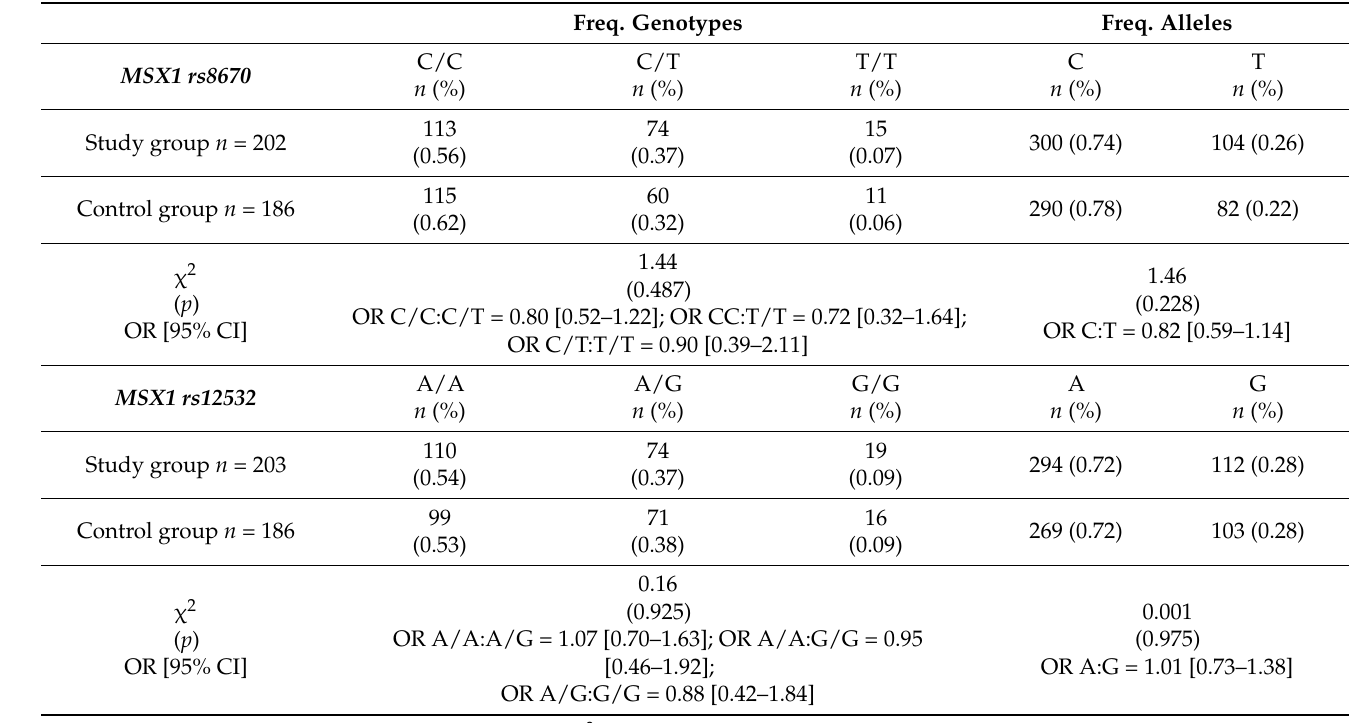
Table 5. Frequency of genotypes and alleles of the MSX1 rs8670 and rs12532 gene polymorphism in the study and control group. Freq. Genotypes Freq. Alleles